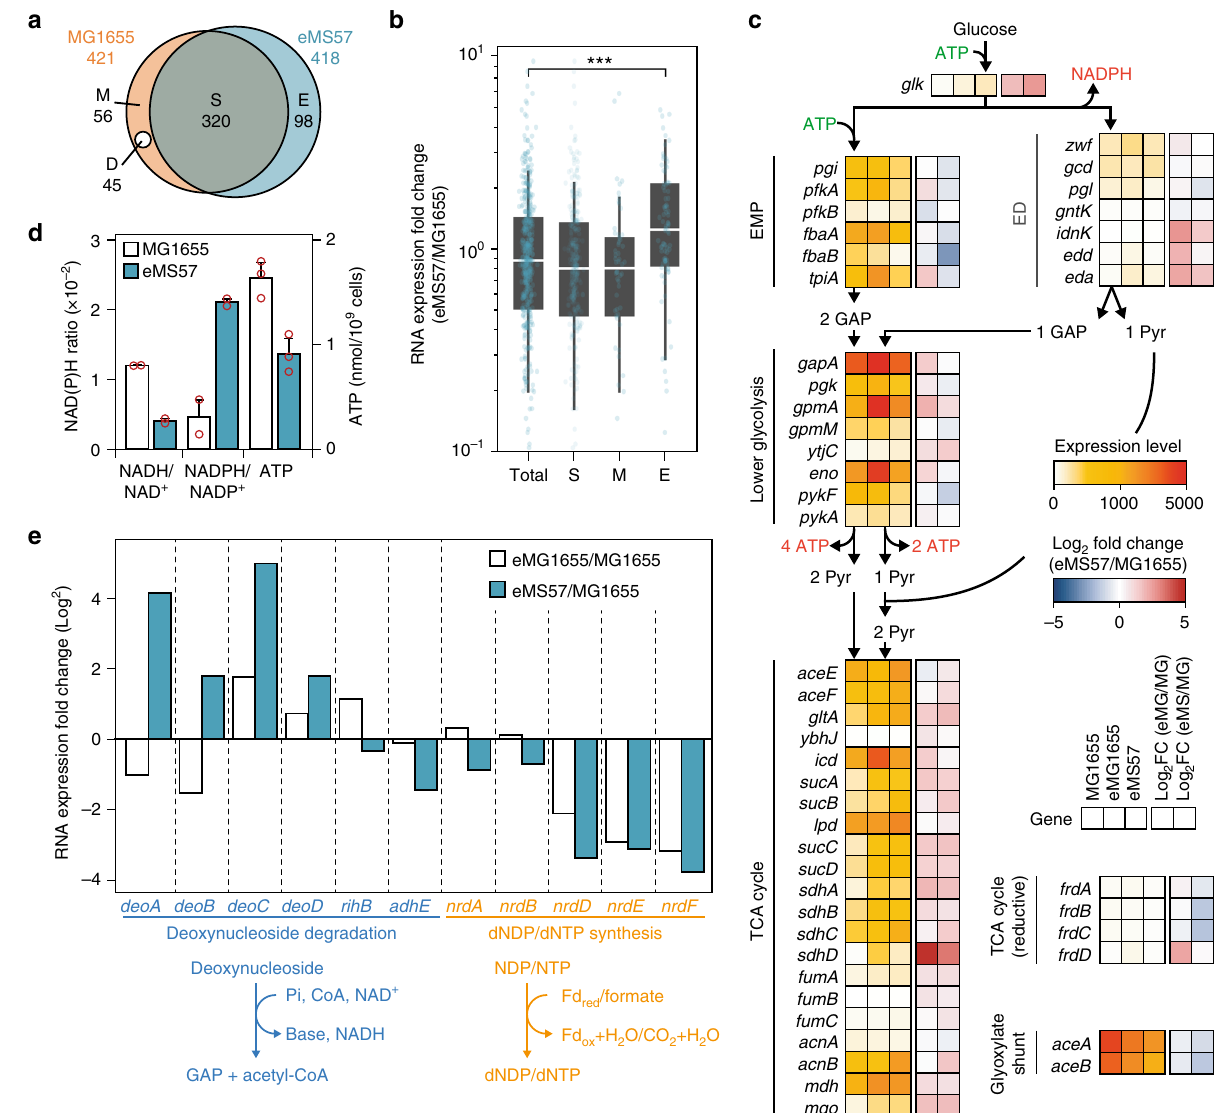
Fig. 3 Transcriptome analysis of eMS57. a A total of 421 and 418 binding sites of σ 70 (MG1655) and mutant σ 70 (eMS57), respectively, were determined by chromatin immunoprecipitation sequencing (ChIP-Seq); 320 sites are shared (S). Except for eMS57 deleted regions (D), wild-type (M) and mutant σ 70 (E) speci fi cally binds to 56 and 98 promoters, respectively. b Box and whisker plots show changes of gene expression between MG1655 and